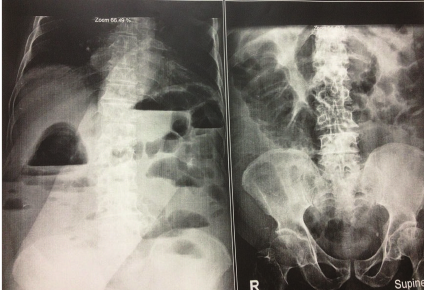
Figure2:AbdominalX-ray(supineandupright)justbeforesurgery.